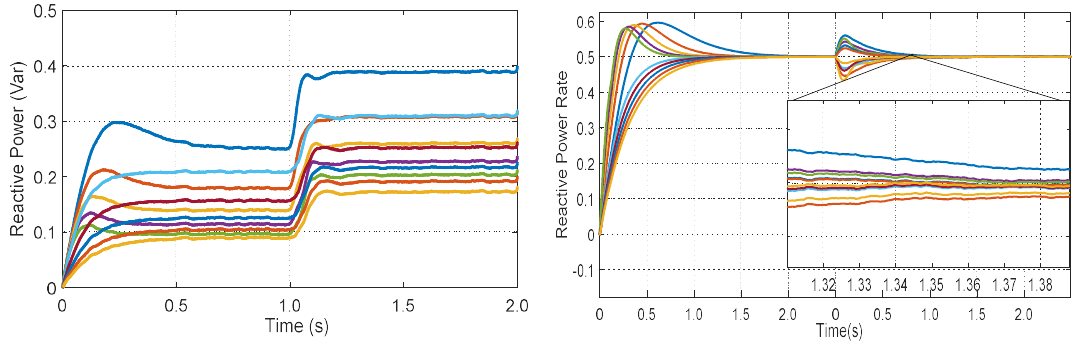
Figure 6. Reactive power output of 10 DGs with ETCP.